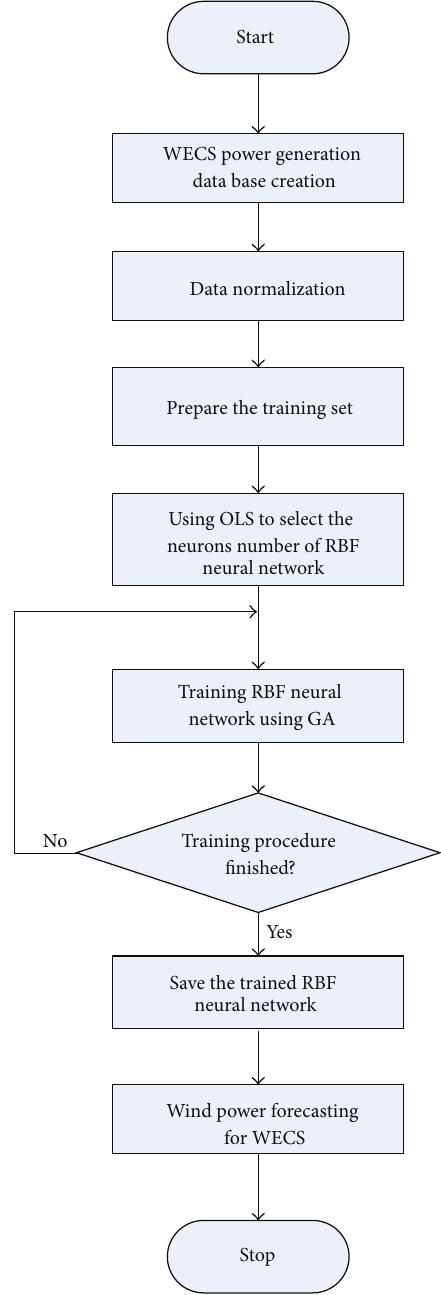
Figure 3: The overall flowchart of the proposed wind power forecasting